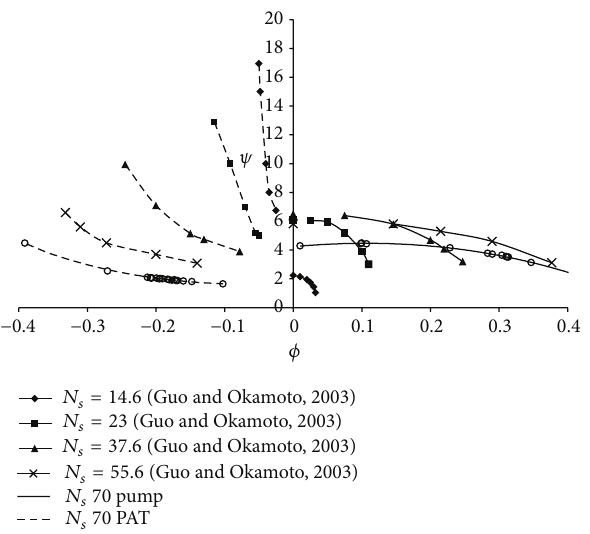
Figure 2: Dimensionless head curves of PAT in pump and turbine modes—comparison to Derakshan et al.